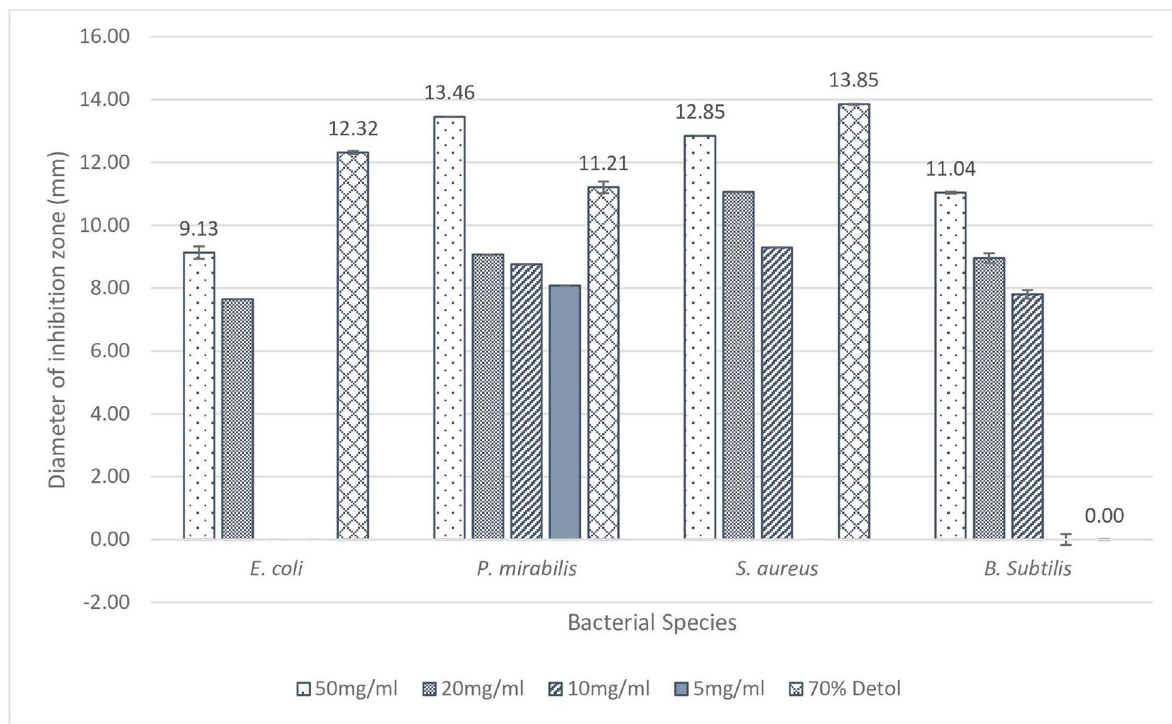
Figure 3. Diameter of the inhibition zone (with standard deviation bars, N = 3) of different concentrations of PJ-WS-LE extract against four bacterial strains using disk diffusion method and upon incubation at 37 °C for 24 h. abcde Within each bacterial species, treatment columns with different letters have their values significantly different as shown by Tukey’s test at p ≤ 0.05.